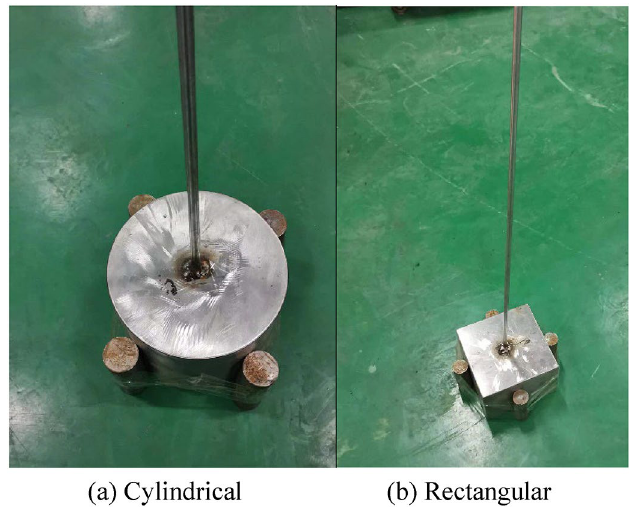
Figure 9. Simulated ore bin with different weight block